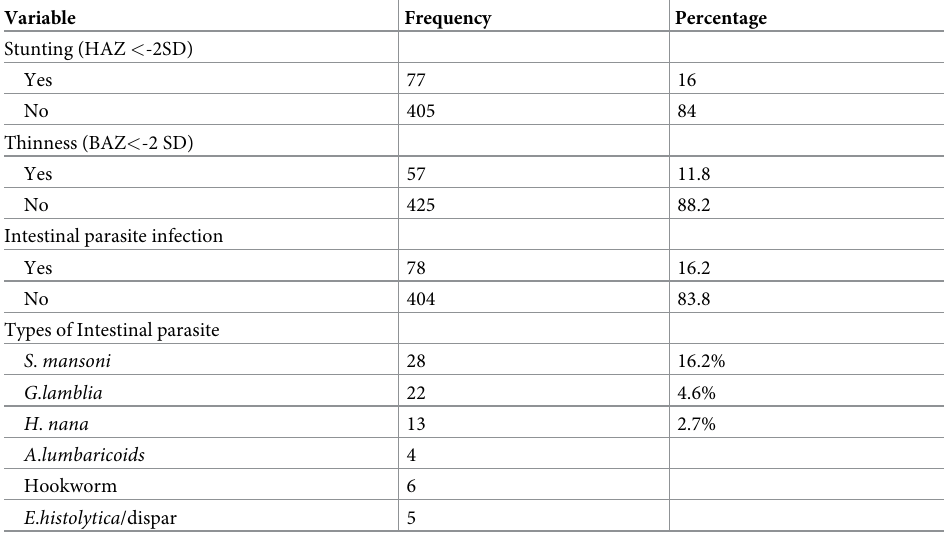
Table 3. Nutritional status and clinical factors of school-children in Kersa Woreda primary schools, eastern Ethi- opia, 2020/21 (n =